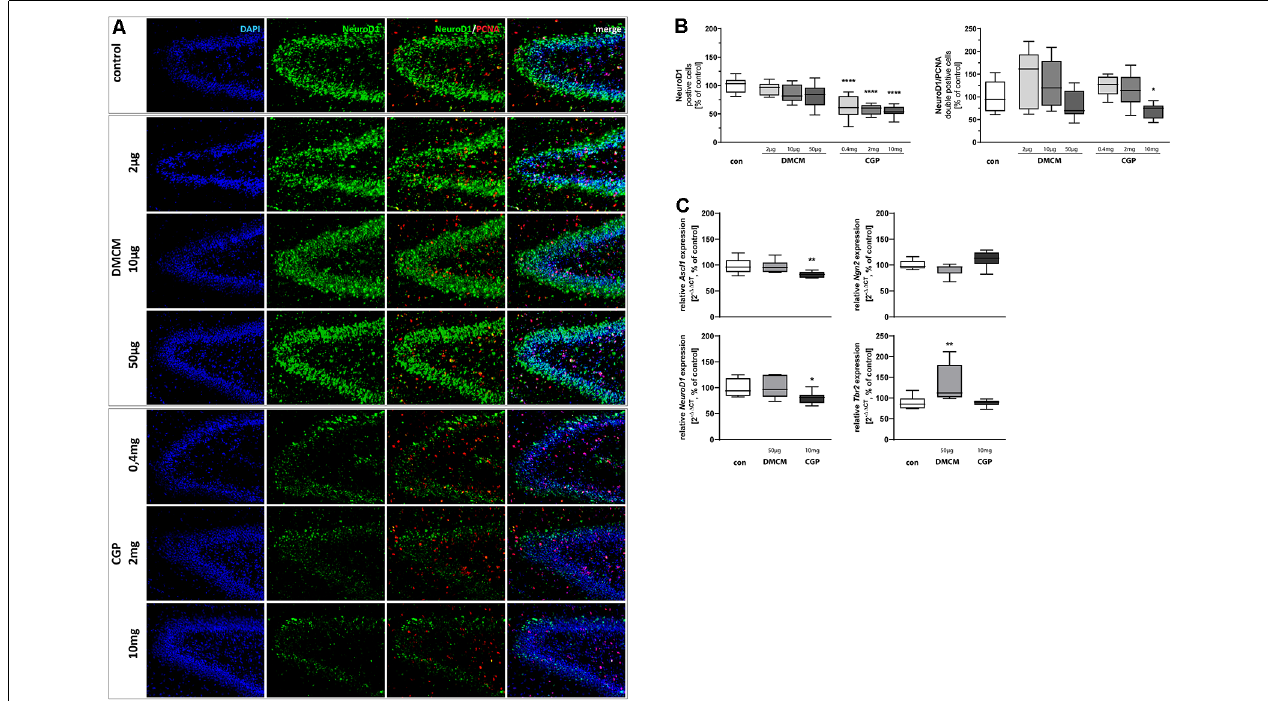
FIGURE 2 | Representative hippocampal paraffin sections (A) of control animals, DMCM hydrochloride (DMCM) in doses of either 2 µ g/kg, 10 µ g/kg or 50 µ g/kg, and CGP 35348 in doses of either 0.4 mg/kg, 2 mg/kg or 10 mg/kg treated rat pups at P11 co-labeled with DAPI, NeuroD1, and PCNA. Application of GABA B receptor antagonist CGP decreased NeuroD1 positive progenitor cells in the DG and NeuroD1/PCNA double positive cells in the group with the highest dose of 10 mg/kg. Quantification of (B) NeuroD1 and NeuroD1/PCNA double positive cells in sum of the DG in comparison to control group (100% white bars). Data are expressed relative to the control group as mean ± SEM of n = 10 each group. The 100% values are for NeuroD1+ 308.9 cell counts and for NeuroD1+PCNA+ 7.7 cell counts. * p < 0.05 and ∗∗∗∗ p < 0.0001 vs. control (one-way ANOVA for NeuroD1+, Brown-Forsythe test for NeuroD1+PCNA+). Expressions of (C) Ascl1 and NeuroD1 are reduced in CGP treated animals and expression of Tbr2 is increased in DMCM treated animals. Ngn2 does not get affected by GABA receptor antagonists. The relative mRNA expressions of markers were measured by quantitative real-time PCR in rat brain homogenates with DMCM 50 µ g/kg (gray bars) or CGP 10 mg/kg (black bars) application relative to control (white bars). Bars represent the relative mRNA quantification based on internal standard HPRT . Data shown as mean ± SEM, n = 9–10. * p < 0.05 and ** p < 0.01 vs. control (one-way ANOVA for Ascl1 and Tbr2 , Kruskal–Wallis test for NeuroD1 , Brown-Forsythe test for Ngn2